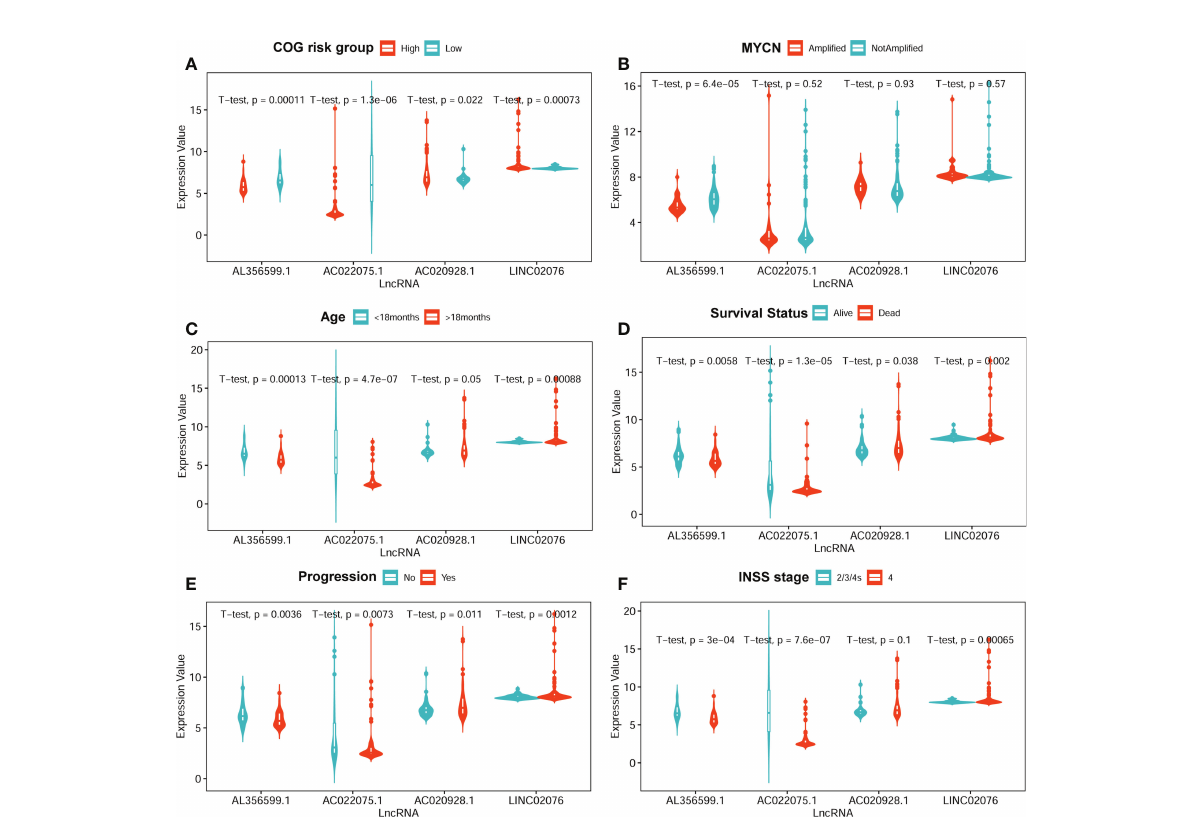
FIGURE 4 The average expression levels of the four lncRNA between different subgroups. (A) COG risk group (high vs low). (B) MYCN ampli fi cation (ampli fi ed vs not-ampli fi ed. (C) Age (< 18 months vs > 18 months). (D) Survival status (alive vs dead). (E) Progression (no vs yes). (F) INSS stage (2/ 3/4S vs 4). The two-sided t-tests p-values were shown. COG, Children ’ s Oncology Group; lncRNA, long noncoding